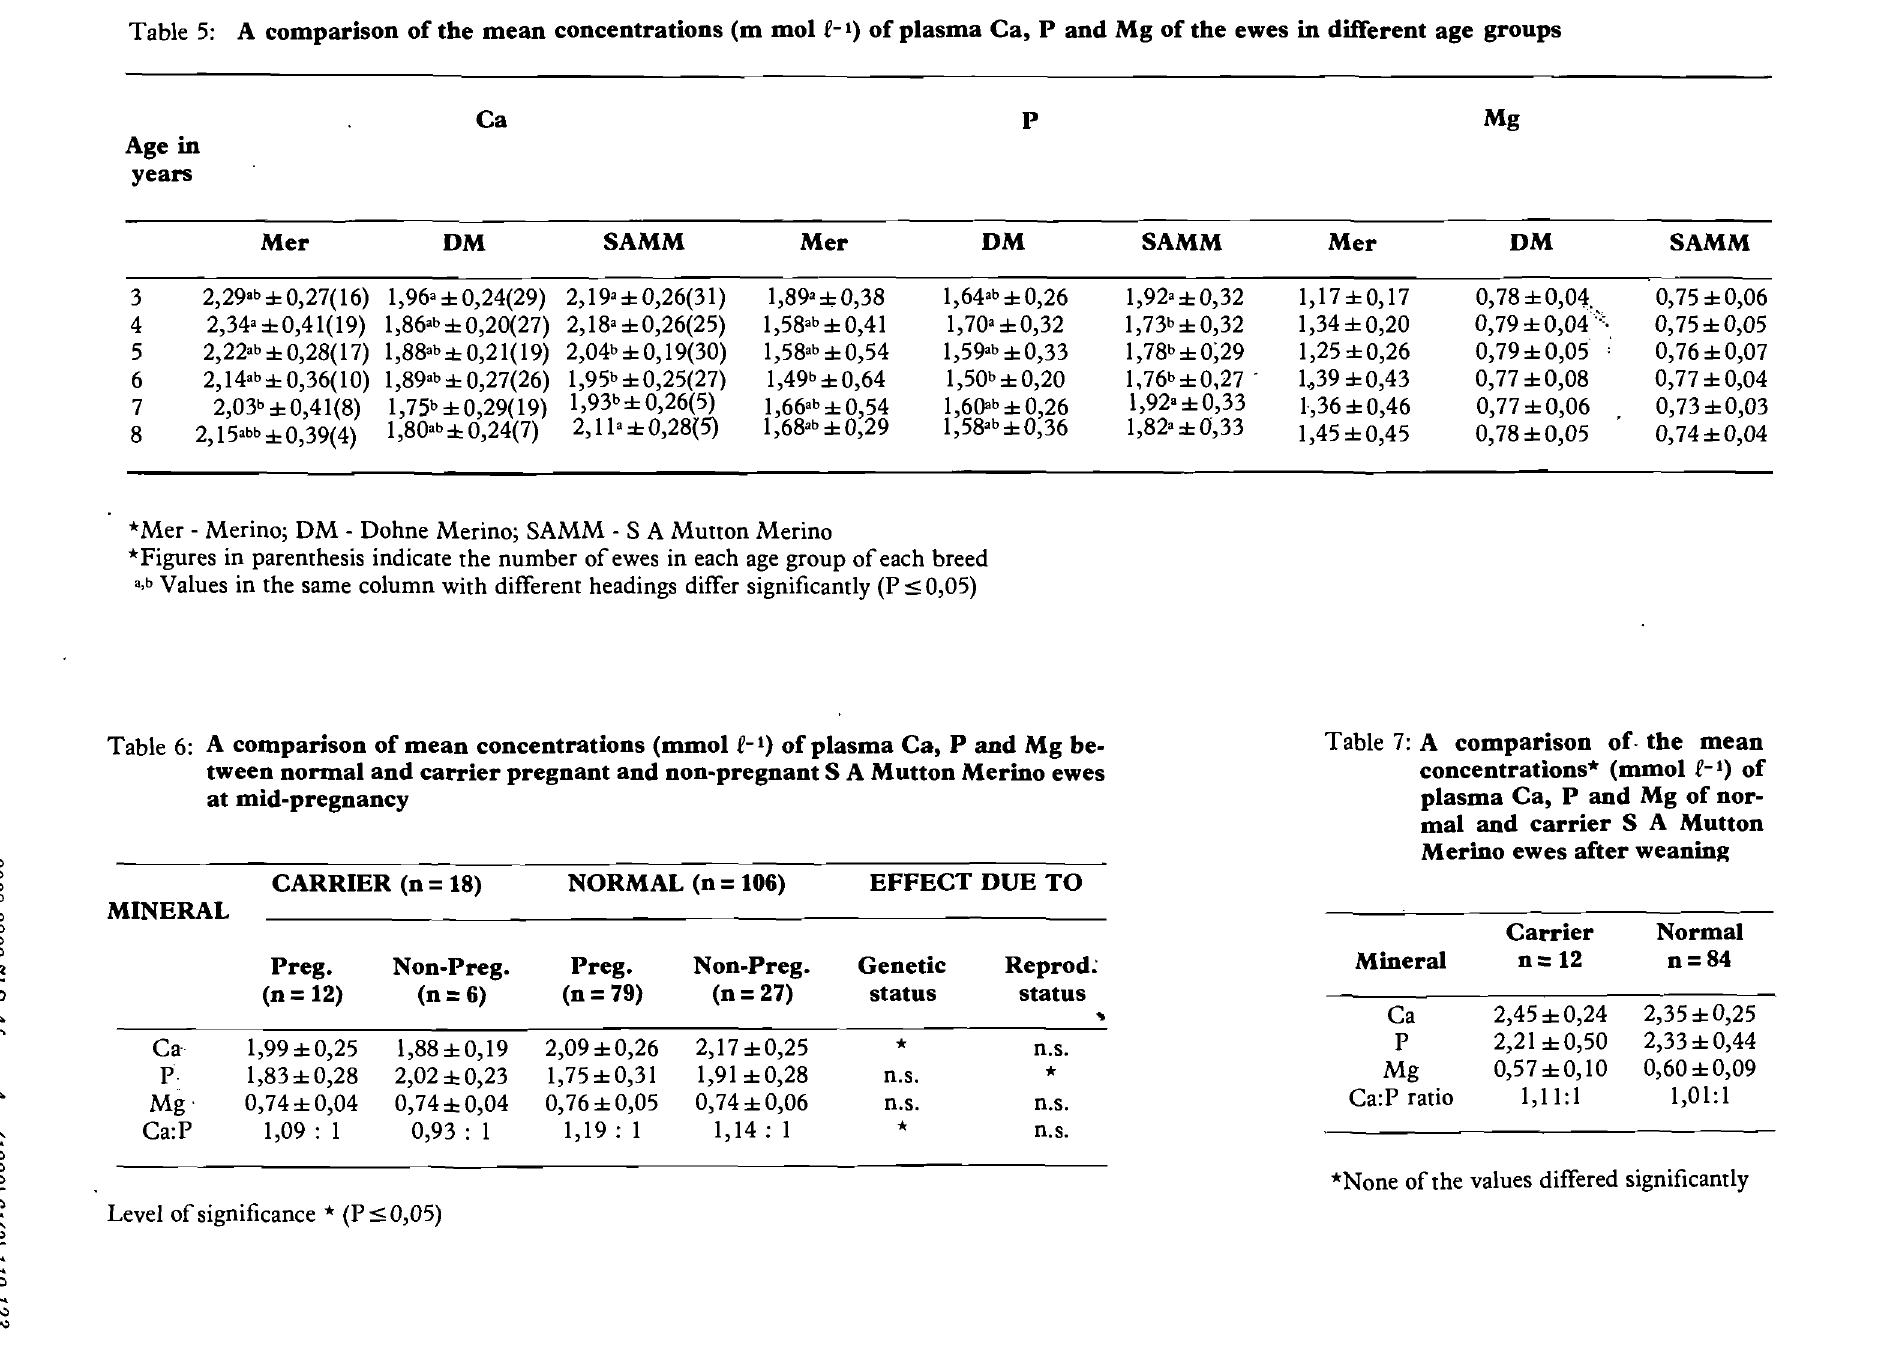
Ca P Age in years Mer DM SAMM Mer DM